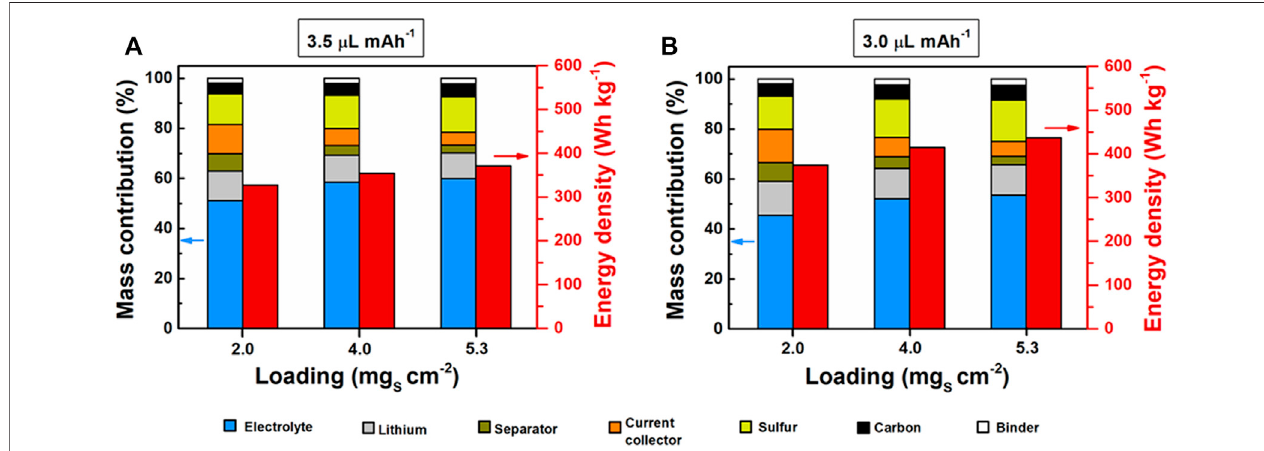
FIGURE 5 | Mass distribution and corresponding energy density of fabricated Li-S pouch cells with (A) E/C ratio = 3.5 µl mAh − 1 and (B) E/C ratio = 3.0 µl mAh − 1 . More detailed information can be found in Supplementary Tables S1, S2 of Supporting